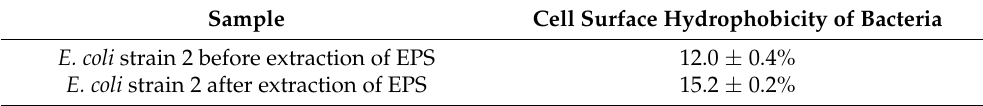
Table 2. Cell surface hydrophobicity for E. coli strain 2 cell surface before and after EPS extraction.